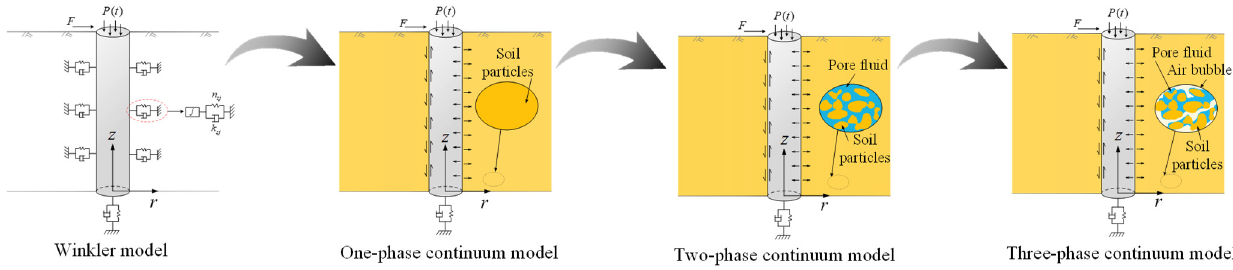
Figure 6. Development of the dynamic soil–pile interaction model.